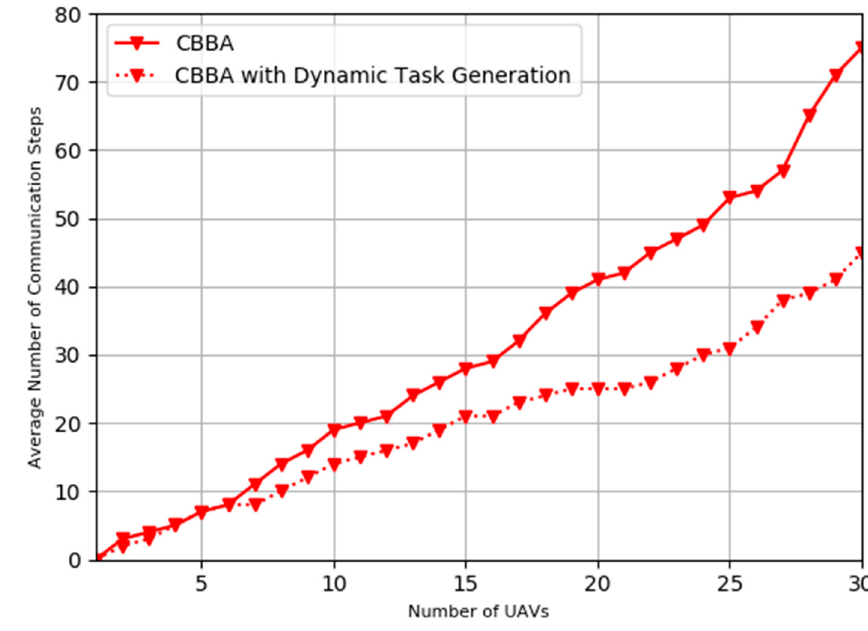
Figure 10. Comparison of average number of communication steps for consensus.